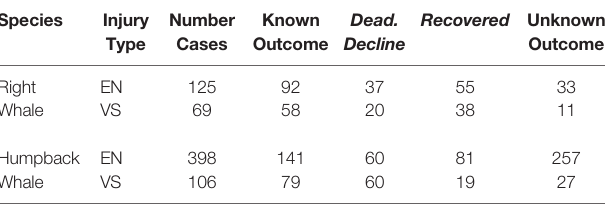
TABLE 1 | Summary of right whale and humpback whale entanglement (EN) and vessel strike (VS) injury cases used in this study.